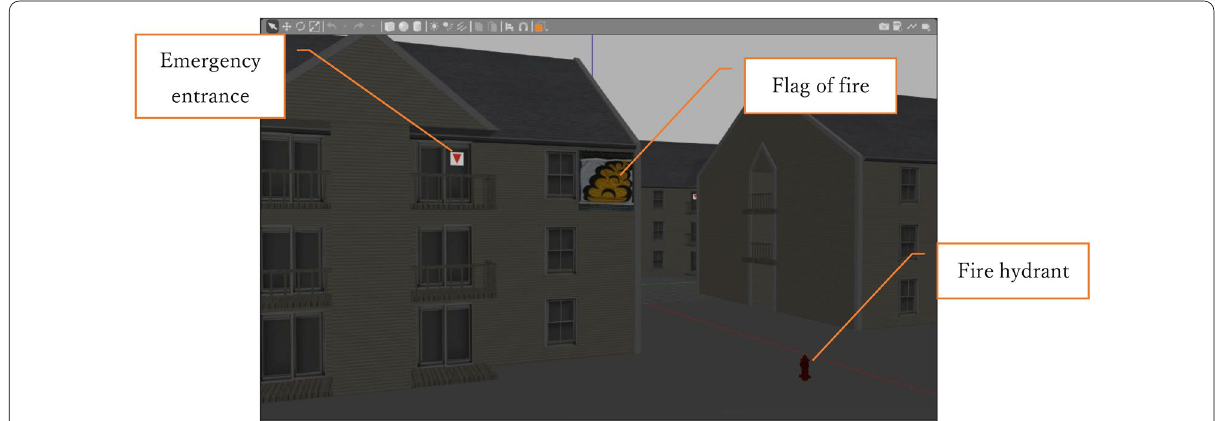
Fig. 5 Equipment in the experimental